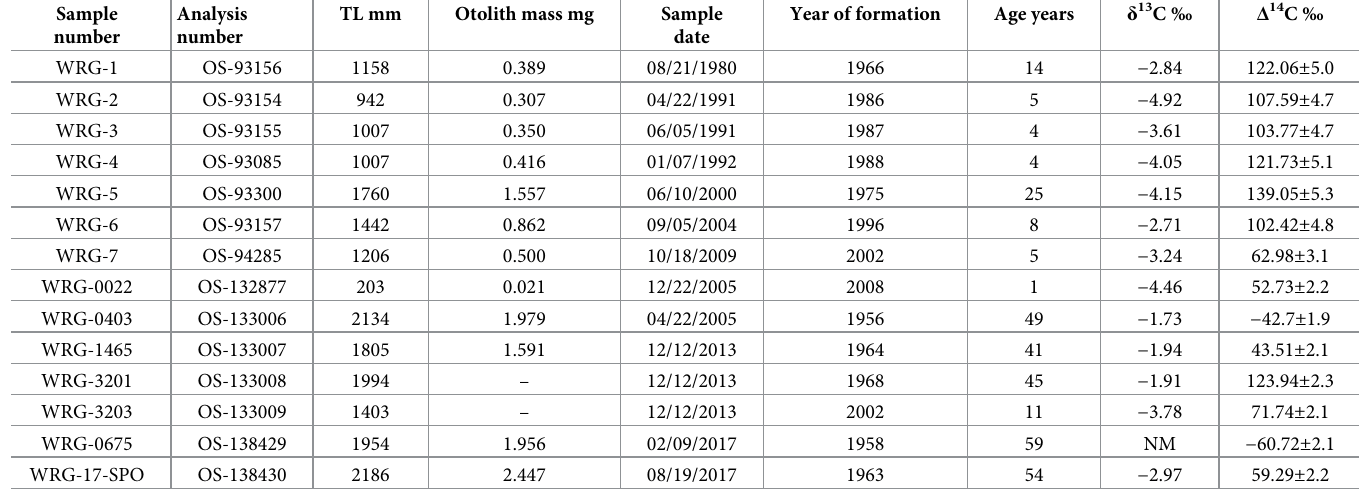
Table 2. Warsaw grouper otolith Δ 14 C samples. Warsaw grouper otolith samples analyzed for Δ 14 C with AMS. Otoliths for which no otolith mass or age estimate was recorded are shown as—. Year of formation equals sample year minus estimated age. NM = not